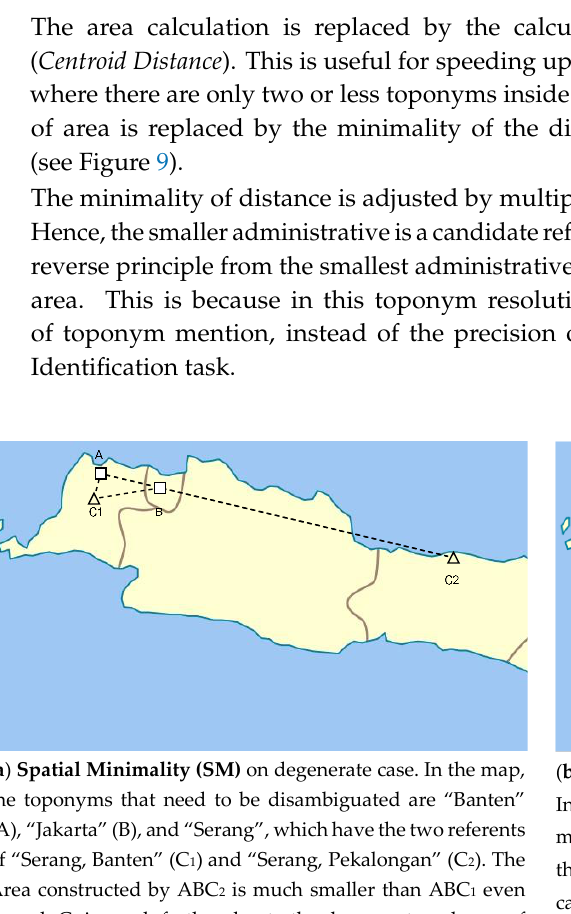
Algorithm 4. Modified Spatial Minimality with Centroid Distance and adjustment factor based on Administrative level and adjustment constant M (SMCD-ADM). function DisambiguateDocumentSMCD-ADM(T: list of toponyms, G: gazetteer): 1: begin 2: for each t in T: 3: